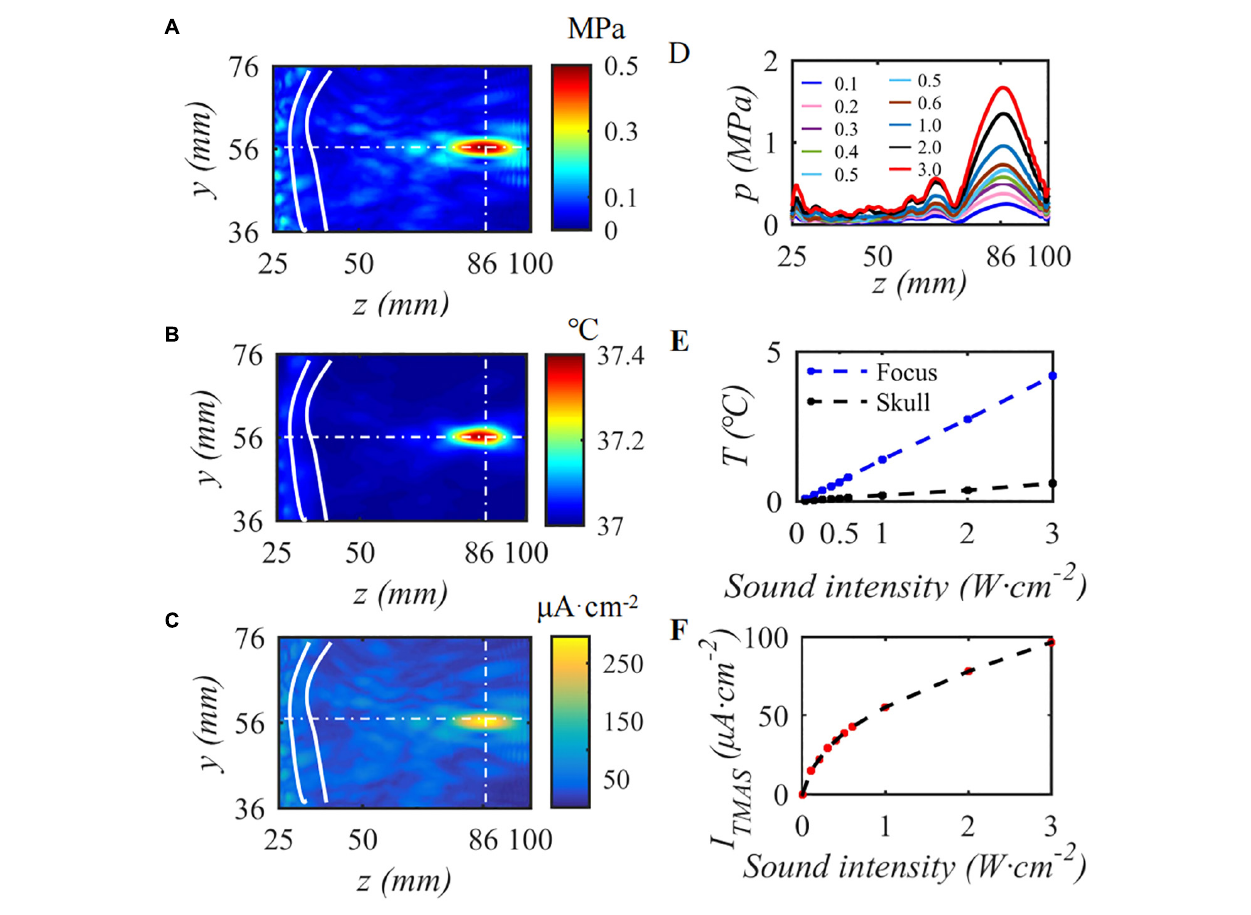
FIGURE 4 | The influence of input sound intensity on TMAS, (A) sound pressure field, (B) temperature field, (C) TMAS-induced field, (D) sound pressure curve at the sound axis, (E) is the temperature rise at the focus and the skull, (F) is the maximum density of the TMAS-induced current at the focal point ( B = 0.3 T, t = 10